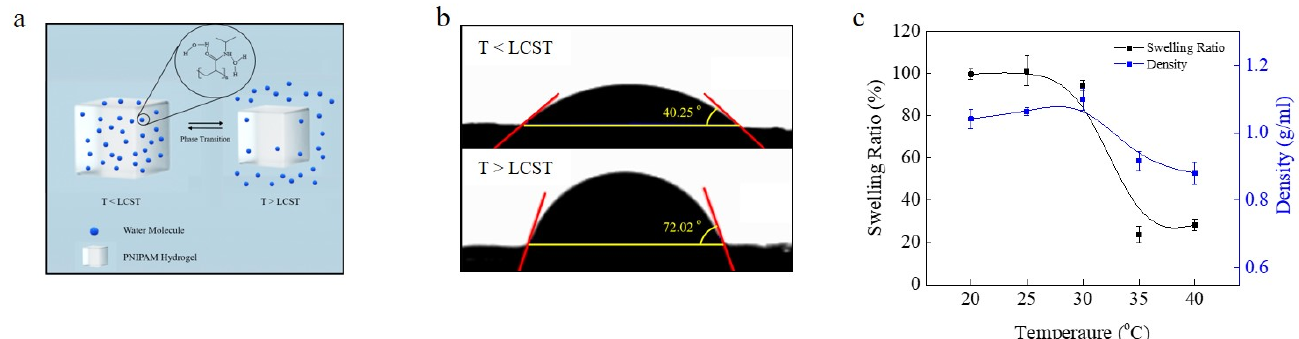
Figure 2. Mechanism of density control during diving/surfacing cycle. ( a ) Schematic image of interaction between PNIPAM molecules and water molecules in each phase of PNIPAM. ( b ) Optical images of contact angle between PNIPAM film and water, which show that PNIPAM becomes less hydrophilic above the phase transition temperature. ( c ) Swelling ratio and density change of PNIPAM device at each temperature.